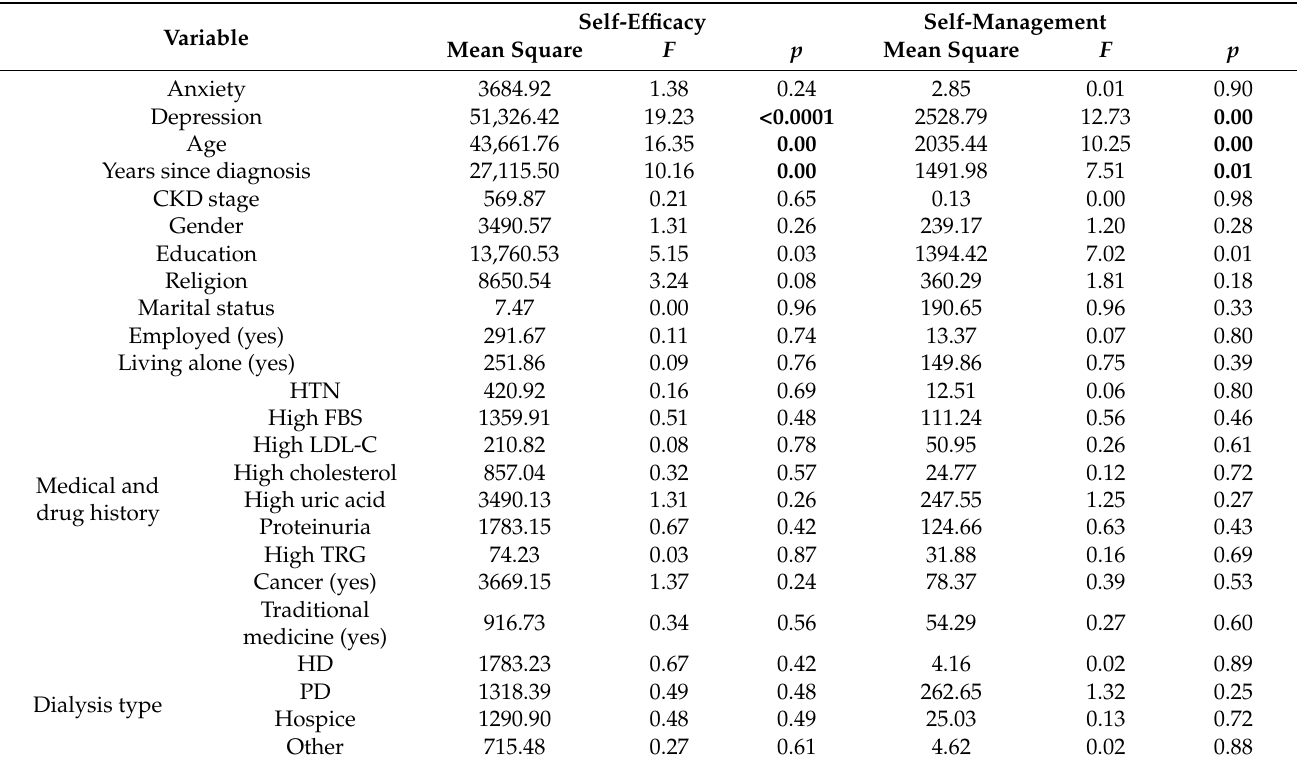
Table 7. Generalized linear models for self-efficacy and